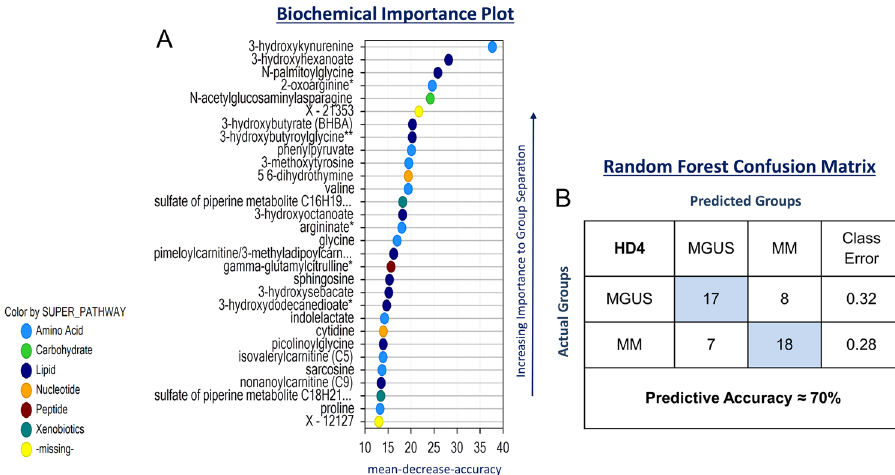
Figure 1. ( A ) Random forest analysis of bone marrow plasma samples from patients with MGUS (N = 25) and MM (N = 25) based on relative levels of metabolites depicting top 30 metabolites responsible for group separation between MGUS and MM. ( B ) Random forest confusion matrix demonstrating the performance of the model generated by the random forest analysis of metabolites in accurately predicting MM and